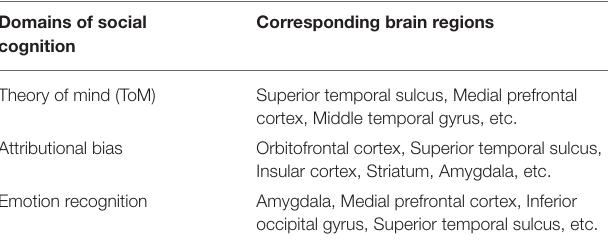
Corresponding brain regions